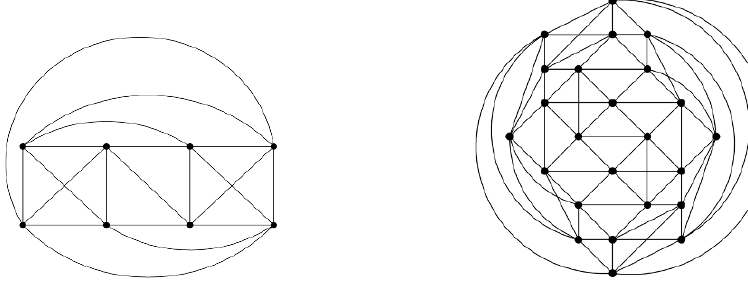
Figure 1. Two extremal IC-planar graphs with respect to Proposition 2.1 and Proposition 2.2